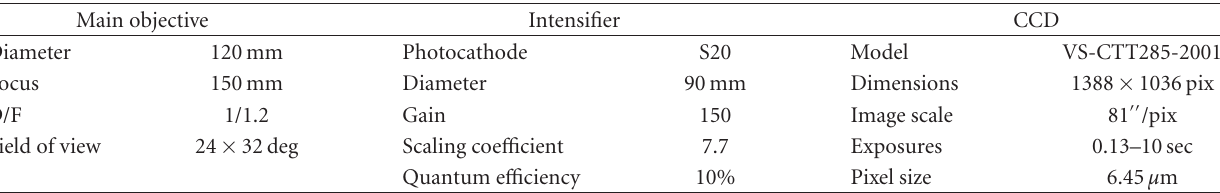
Table 2: Technical parameters of TORTORA camera.